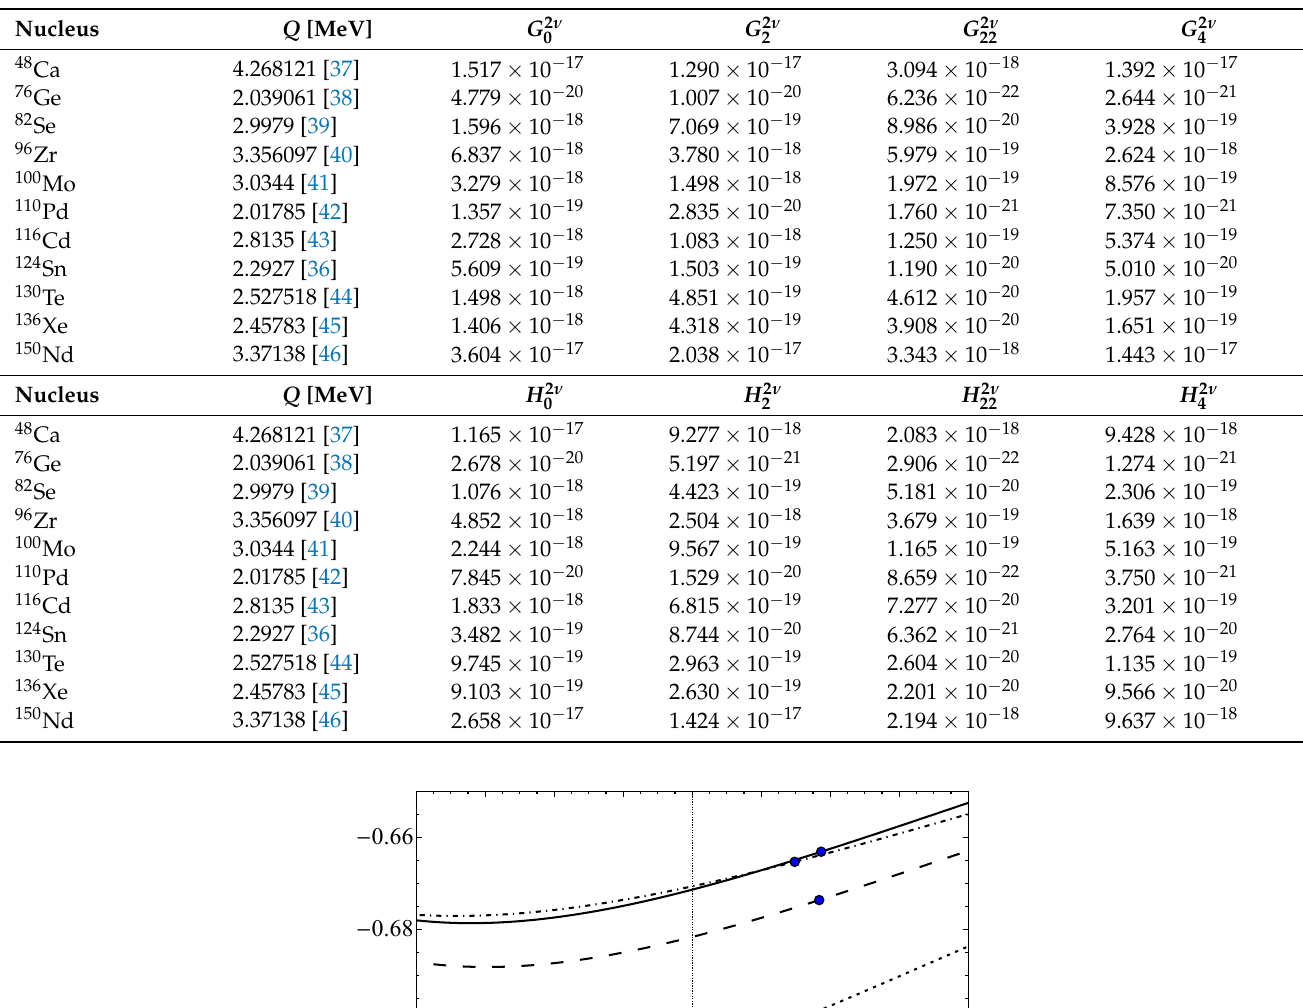
Table 2. Phase space factors G 2 ν and H 2 ν with N = { 0,2,22,4 } , in yr − 1 , obtained using the screened exact finite-size N N Coulomb wave functions for s 1/2 electron state. The Q values are taken from the experiments with the smallest uncertainty when available, or from tables of recommended value [36].